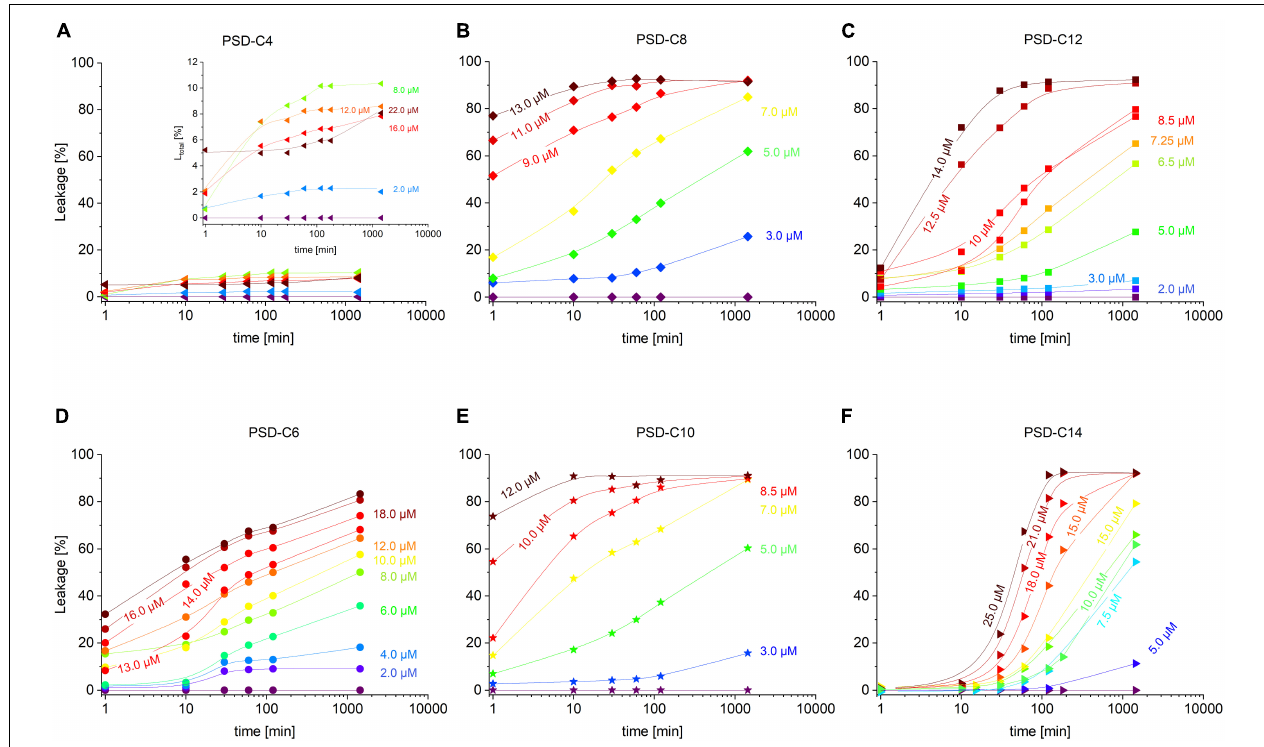
FIGURE 4 | Cumulative leakage kinetics over 24 h of calcein-LUVs (=30 µ M) induced by PSD-C4 (A) , PSD-C6 (D) , PSD-C8 (B) , PSD-C10 (E) , PSD-C12 (C) , and PSD-C14 (F) . The amount of total leakage (=released calcein) in % is shown as a function of time on a logarithmic scale. Investigated time points are right upon addition of the active compound and after 10, 30, 60, 120, (180 for PSD-C4 and PSD-C14), and 1440 min incubation time. Lines are to guide the eye, whereas the rainbow color code changes from purple (=0 µ M PSD addition) to dark red with increasing concentrations of the respective active PSD variant, as